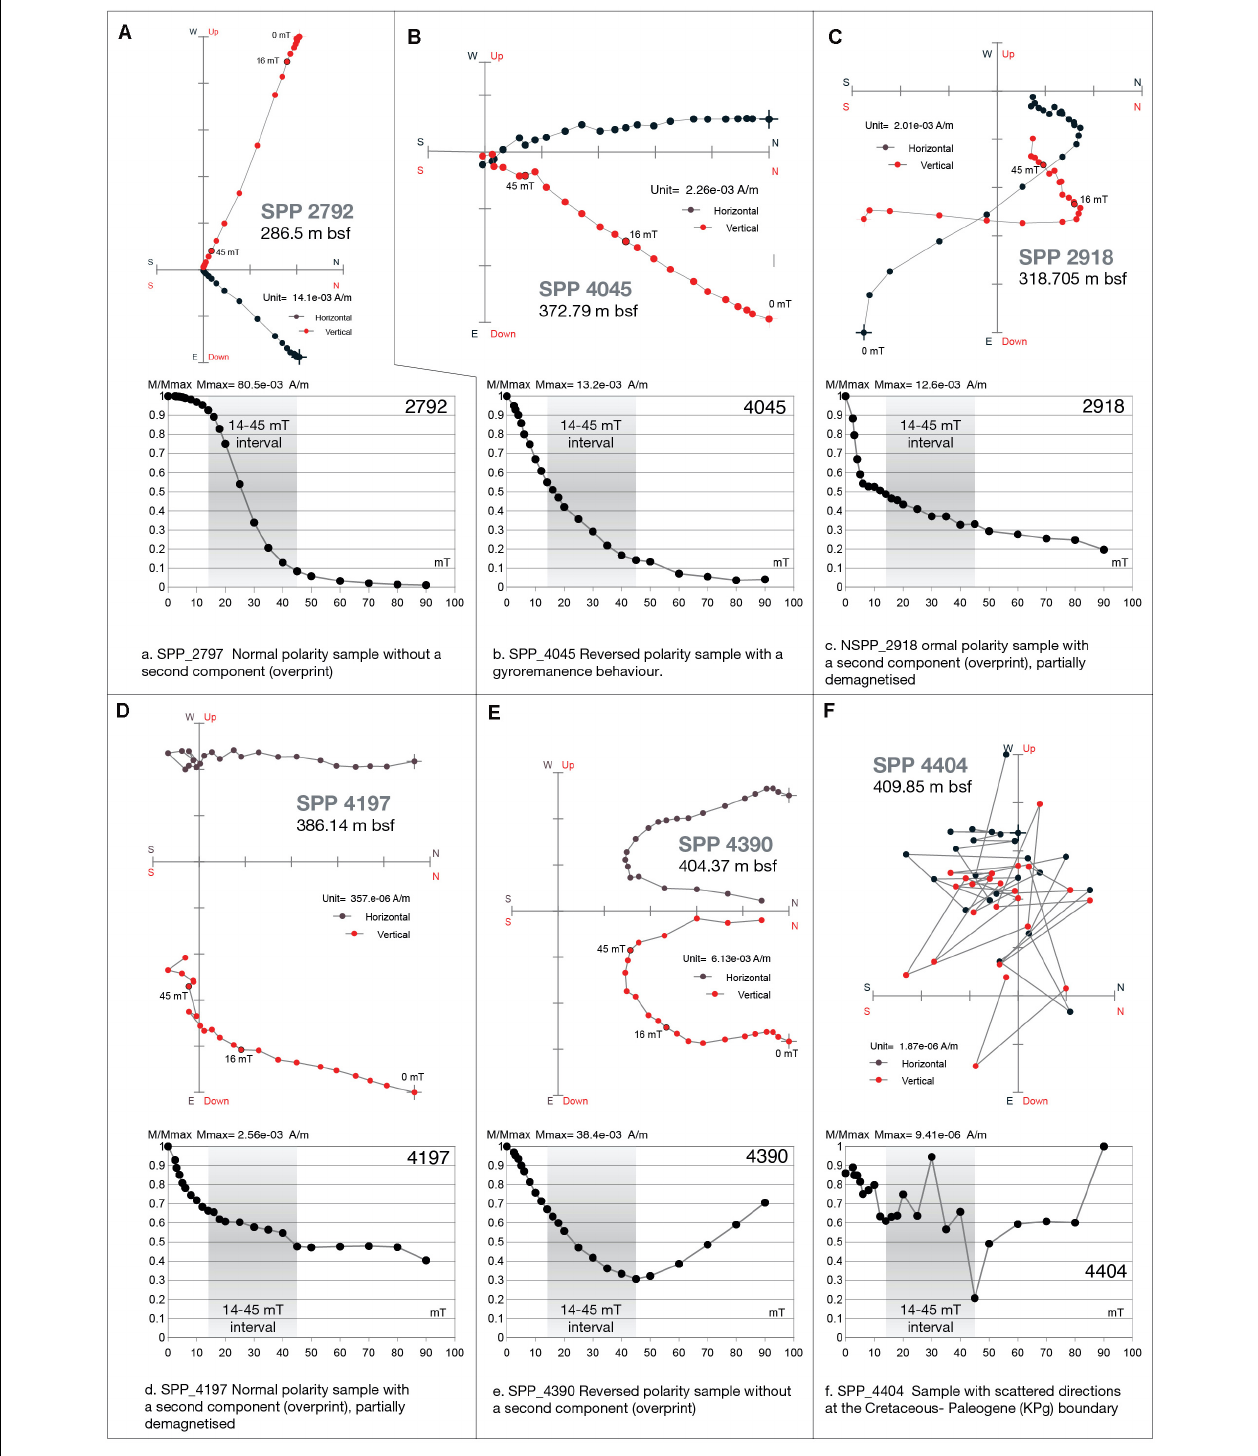
FIGURE 3 | Key types of magnetic behavior illustrated with Zijderveld diagrams and magnetic intensity plots. Samples (A–C) are considered reliable NRM carriers due to their stable directions during the demagnetization process, while samples (D–F) . are examples of problematic demagnetization: sample (D) does not demagnetize, sample (E) acquires a magnetic field in the course of demagnetization and sample (F) exhibits an erratic behavior during demagnetization.